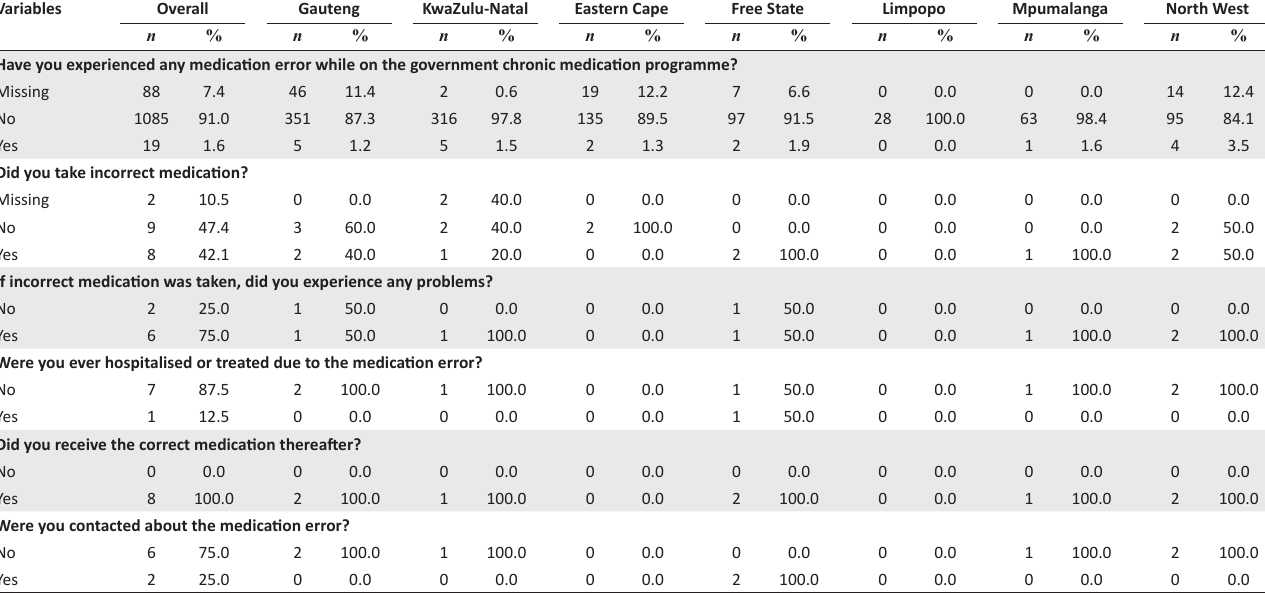
TABLE 3: Medication errors reported by patients on the tenofovir disoproxil fumarate/lamivudine/dolutegravir regimen in the survey. Variables Have you experienced any medication error while on the government chronic medication programme? Missing